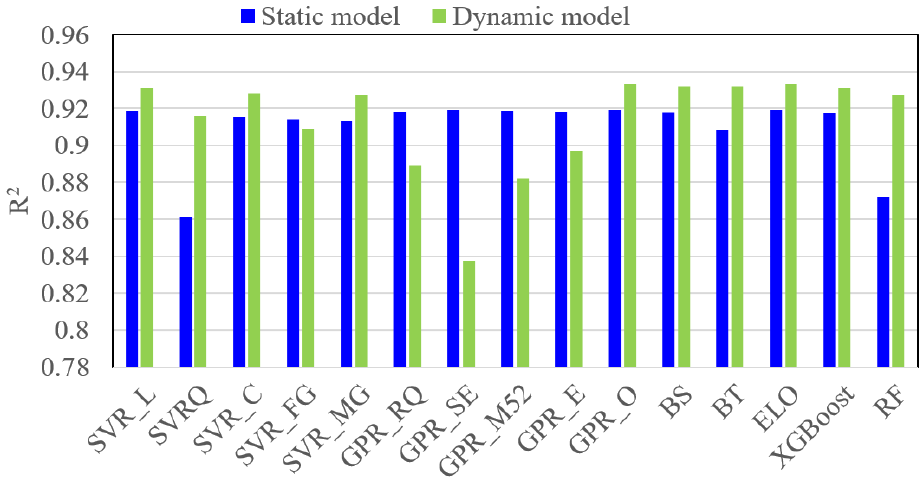
Figure 13. Avreaged R 2 values of static and dynamic